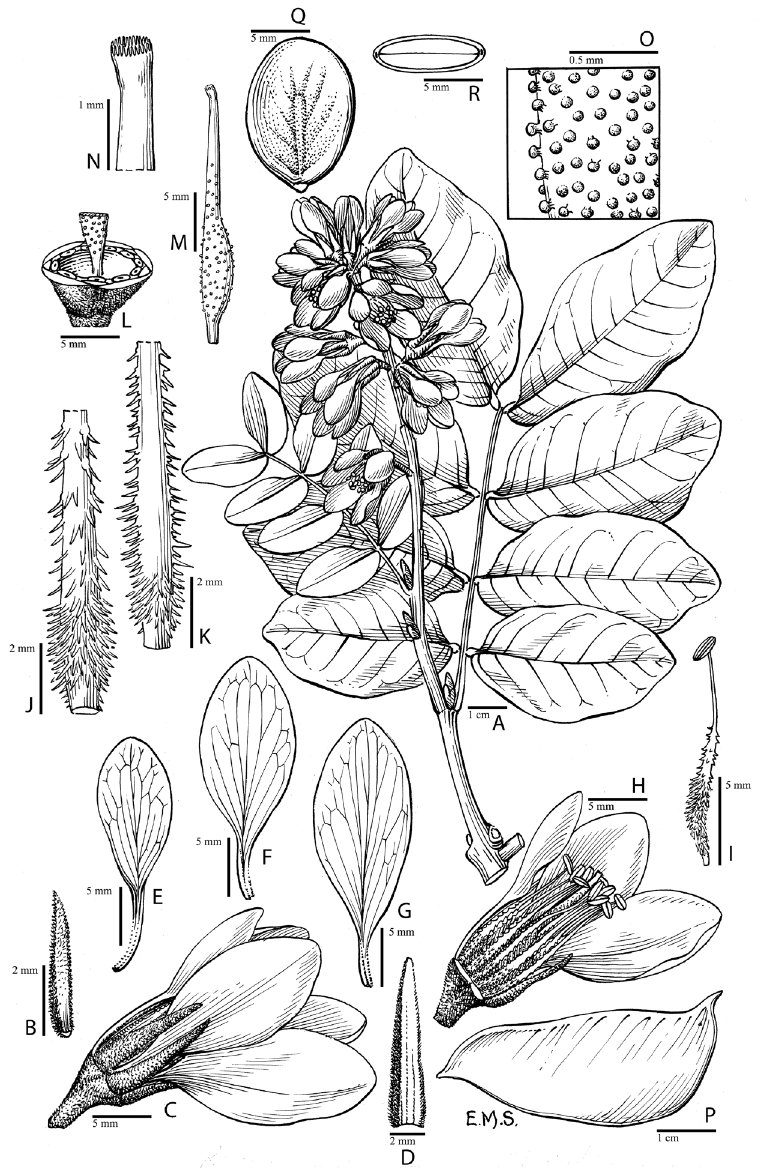
Figure 28. Stuhlmannia moavi Taub . A inflorescence and pinnate leaf B flower bract C flower D sepal E median petal F upper lateral petal G lower lateral petal H flower with sepals and petals removed from one side to show arrangement of stamens I stamen J lower portion of stamen filament, seen from inside the flower K lower portion of stamen filament seen from outside the flower L hypathium after fall of sepals, petals and stamens M gynoecium, N stigma and apical portion of style O detail of outer surface of ovary showing sessile glands P fruit Q seed R transverse section of seed. A from Tanner 3167 B, P–R from Tanner 3724 C–O from Tanner 2467. Drawn by E. M. Stones, originally published in Hooker`s Icones Plantarum, Tab. 3626